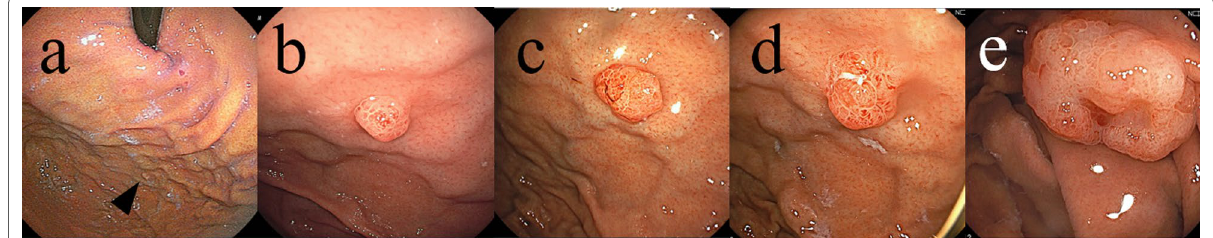
Fig. 1 EGD showed a polypoid lesion at the lesser curvature of the proximal stomach. The lesion became larger. a A half year, b a year, c one and a half years, d 2 years, e 3 years from endoscopic submucosal dissection for an early gastric